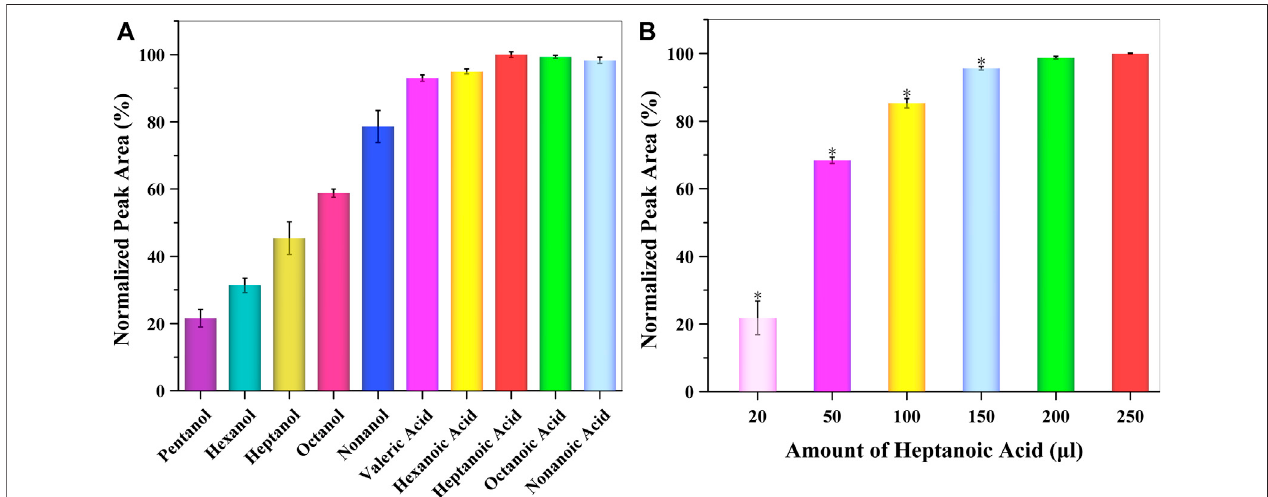
FIGURE 4 | Effect of the (A) type and (B) amount of amphiphile on extraction ef fi ciency ( n (cid:2) 3; * p < 0.05).